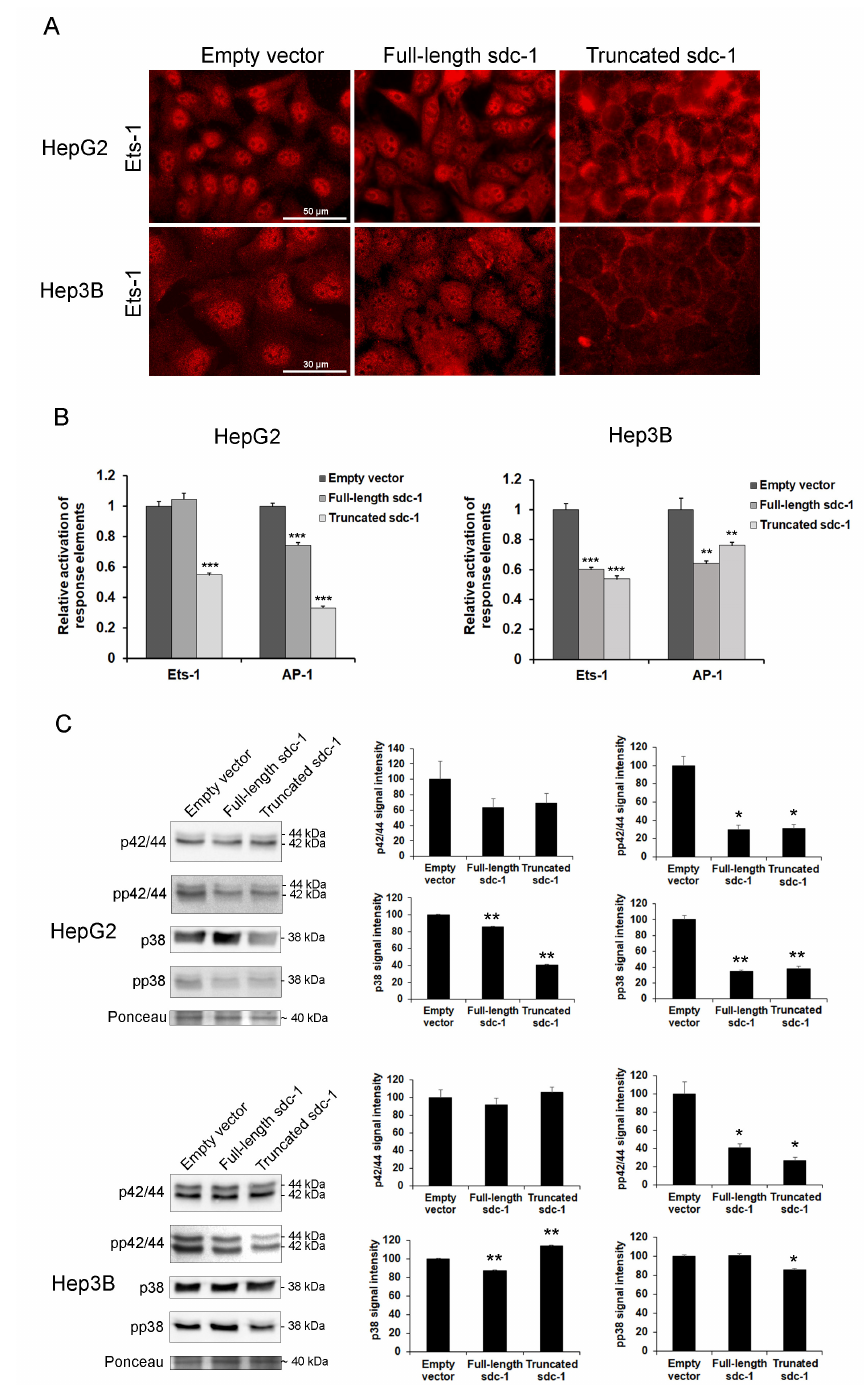
Figure 7. Decreased activity of Ets-1 and AP-1 upon syndecan-1 overexpression. ( A ) Intensive nuclear Ets-1 immunopositivity was present in the empty vector-transfected hepatoma cell lines. A modest decrease of the staining intensity was found in the full-length syndecan-1 transfected cells, whereas nuclei of truncated syndecan-1 transfectants showed hardly any Ets-1 immunoreaction. The protein was partially (full-length) or totally (truncated) sequestered in the cytoplasm; ( B ) In HepG2, decreased Ets-1 response element-driven promoter activity was found in the truncated transfectants, whereas AP-1 response element-driven promoter activity was suppressed in both full-length and truncated syndecan-1 cell lines. In Hep3B, both syndecan-1 constructs interfered with Ets-1 and AP-1 response element-driven promoter activity; ( C ) Transfection with either syndecan-1 construct inhibited the activation of ERK1 / 2 and p38 MAP kinases. Data points represent the mean ± SD, (B) n = 3, (C) n = 2; * p < 0.05; ** p < 0.01; *** p < 0.001 versus the empty vector transfectant. Representative images are at 600 × magnification (scale bar 30 µ m) and 400 × magnification (scale bar 50 µ